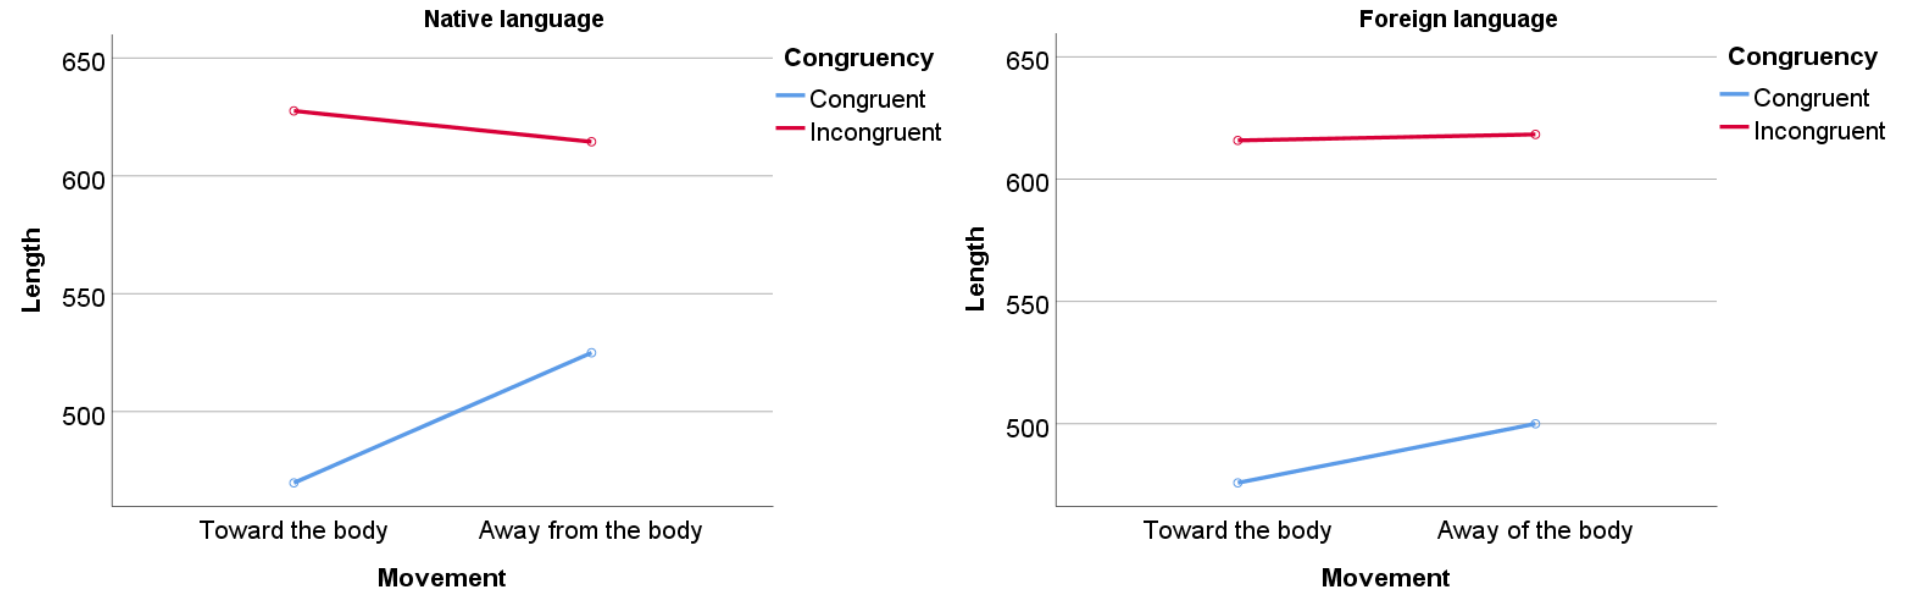
Figure 2 - Length of the trajectory of movement when using the native and foreign language DOI: